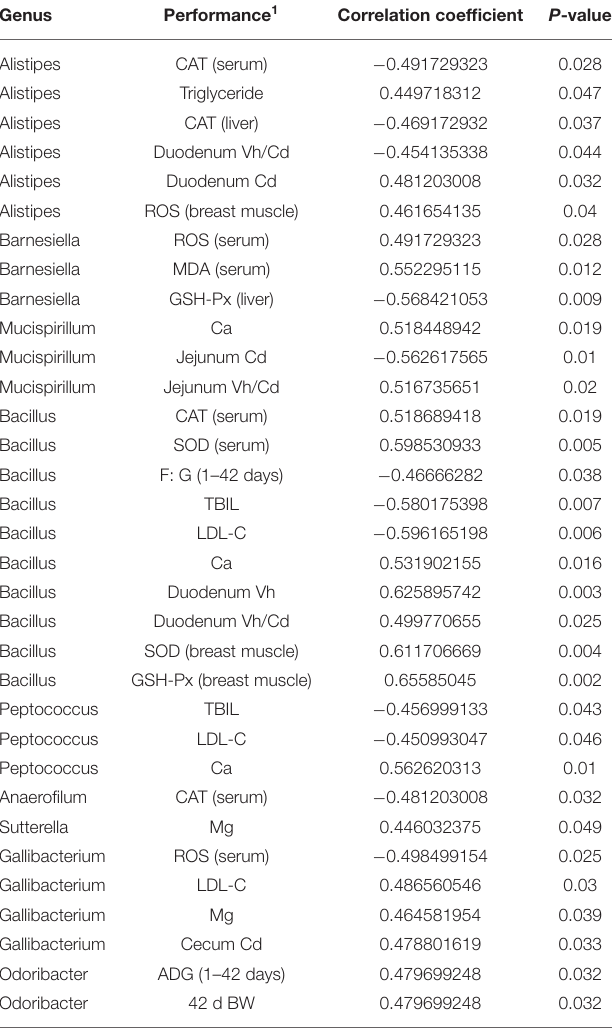
TABLE 7 | The differential genera that were separately correlated with growth performance, blood metabolites, antioxidant status, and intestinal morphology in 42-day-old broiler chickens by using the Spearman’s correlation analyses ( n =